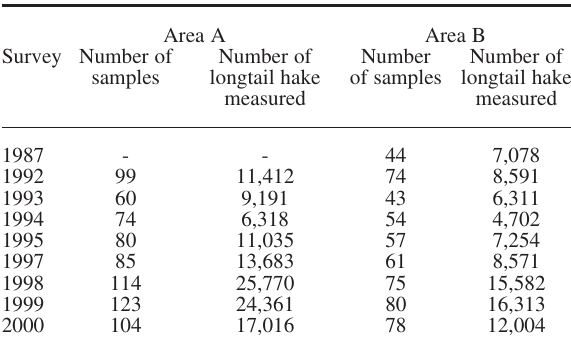
T ABLE 2. – Number of samples and individuals measured during the different